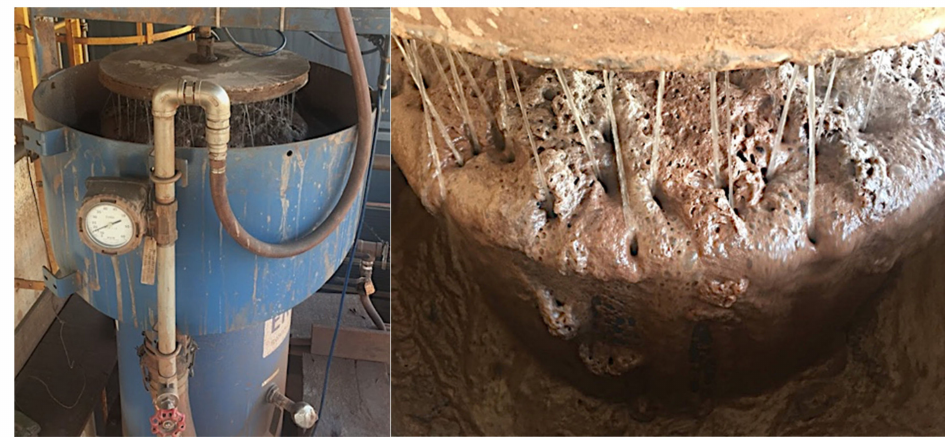
Figure 21. Washing water system during the pilot